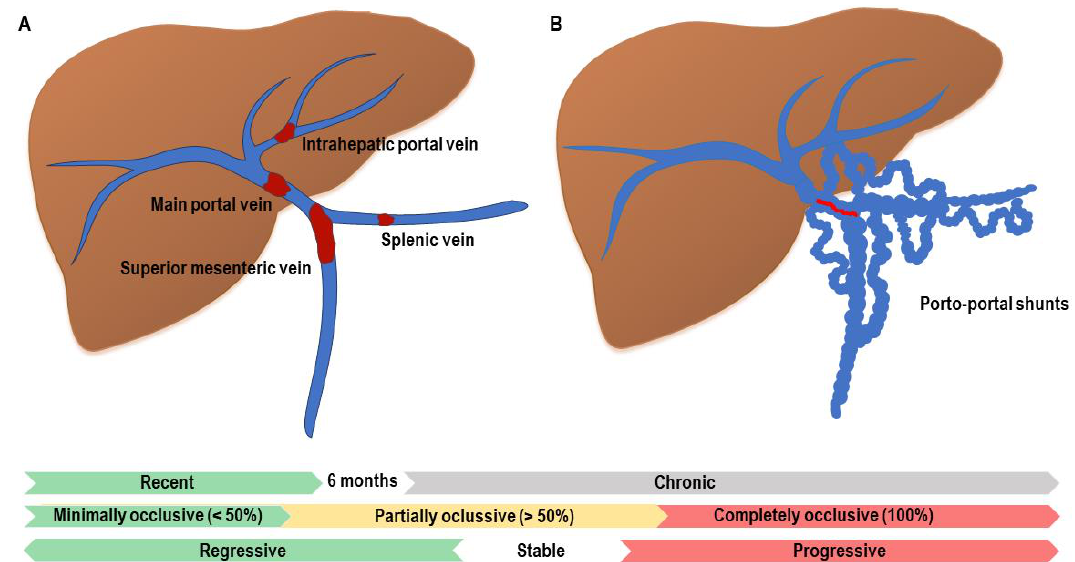
Figure 2. Classification of portal vein thrombosis. ( A ) It is crucial to characterize the extension of the portal vein thrombosis and its relationship with the main portal vein (MPV). The involvement of the superior mesenteric vein (SMV) and splenic vein (SV) should be properly characterized due to its implication in prognosis and treatment. ( B ) Cavernous transformation of the portal vein. Atrophy of the MPV (marked in red) secondary to chronic PVT causes hypertrophy in the vasa vasorum of the portal vein with the apparition of porto-portal shunts. Table 1. Classification of portal vein thrombosis according several authors.